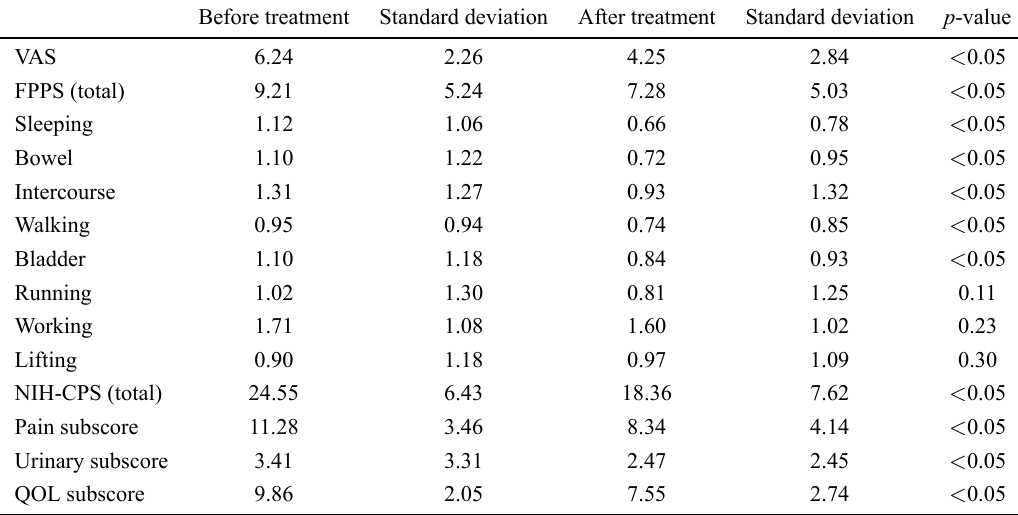
Fig. 4. Average VAS, FPPS, and NIH-CPSI before and after treatment. “Before” refers to new patient consult and “After” refers to 3 month follow up. Table 2. Results table. Before treatment Standard deviation After treatment Standard deviation p